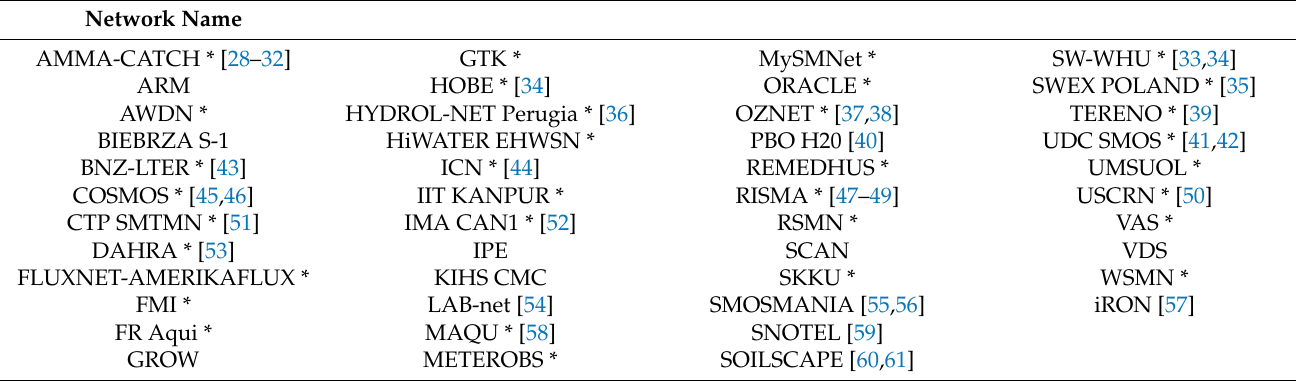
Table 2. In situ networks that are extracted from the ISMN and included in the evaluation. An asterisk [*] is used for sites that are only used for SMOS caused by the shorter temporal coverage of